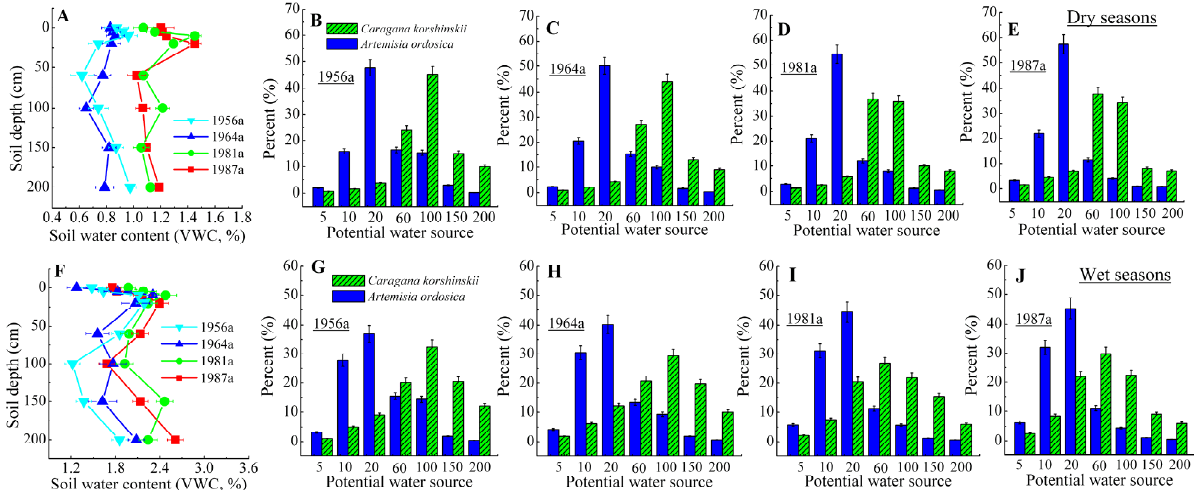
Figure 3. Soil water content and proportion of potential water source for C. korshinskii and A. ordosica in different revegetated sites during dry seasons (25 April 2013 data) and wet seasons (25 October 2013 data) (mean ±